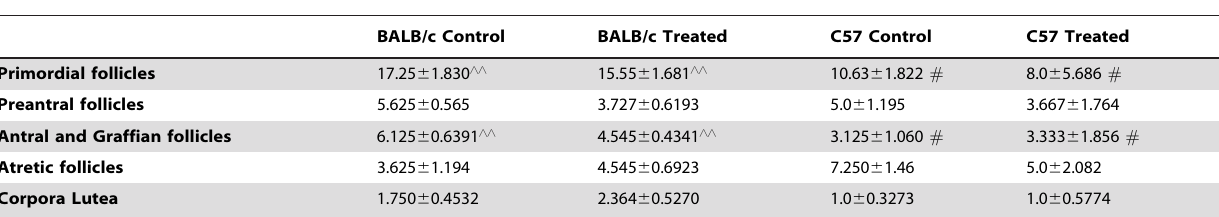
Table 1. Ovarian follicular